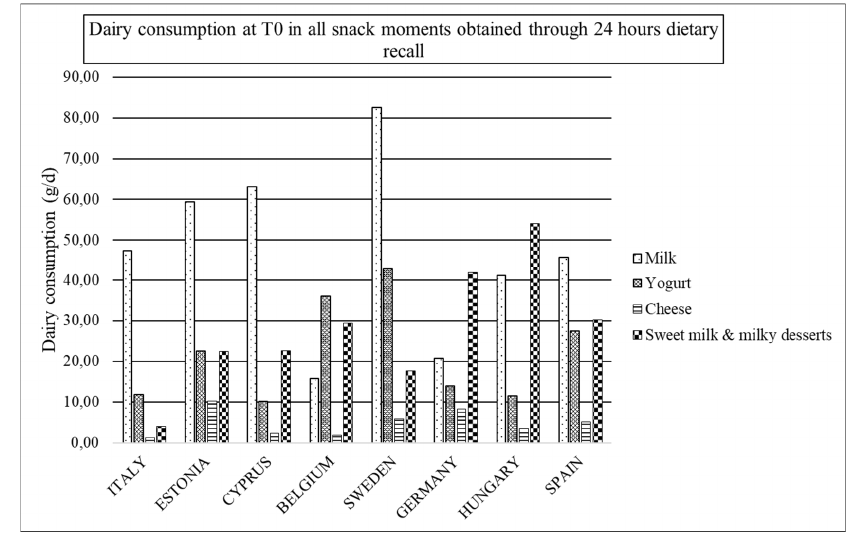
Figure 2. Dairy consumption at T0 in all snack moments obtained through 24 HDR.